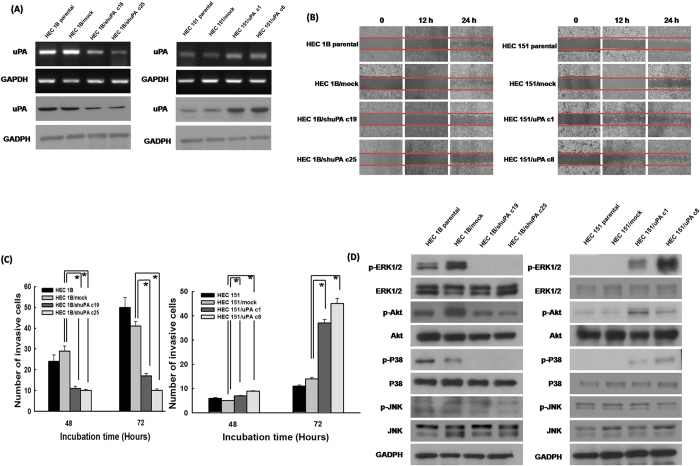
The expression level of uPA correlated with the migration and invasion of endometrial tumor cells and the phosphorylation of ERK1/2, Akt and p38 phosphorylation.(A) RT-PCR and Western blot analyses of uPA expression in various endometrial tumor cells and their transfectants. Note: The expression levels of uPA decreased in HEC1B/shuPA c19 and HEC1B/shuPA c25 cells compared to those in HEC1B parental and HEC1B/mock cells. However, the expression levels of uPA in HEC151/uPA c1 and HEC151/uPA c8 cells were higher than those in HEC151 parental and HEC151/mock cells. (B) Representative images of migration assays in various endometrial tumor cells and their transfectants. Note: Both HEC1B/shuPA c19 and HEC1B/shuPA c25 cells with a low uPA expression showed significantly fewer migrating cells than parental HEC1B and HEC1B/mock cells. However, both HEC151/uPA c1 and HEC151/uPA c8 cells with a high uPA expression had more migrating cells than the parental HEC151 and HEC151/mock cells. (C) Bar graph depicting the number of invasive cells by Boyden chamber analysis. Note: The low uPA-expressing HEC1B/shuPA c19 and HEC1B/shuPA c25 cells had a lower number of invasive cells than the parental HEC1B or HEC1B/mock cells (* indicates p < 0.001, one-way ANOVA). However, the high uPA-expressing HEC151/uPA c1 cells and HEC151/uPA c8 cells had a 2-fold higher number of invasive cells at 72 hours compared with the parental HEC151 and HEC151/mock cells (* indicates, p < 0.001, one-way ANOVA). (D) Western blotting analysis of phosphorylation of ERK1/2, Akt, JNK and p38 molecules. The phosphorylation of ERK1/2, Akt and p38 was consistently downregulated when the expression of uPA in tumor cells (HEC1B/shuPA c19 and HEC1B/shuPA c25 cells) decreased. The uPA highly-expressing tumor cells (HEC151/uPA c1 and HEC151/uPA c8 cells) revealed higher ERK1/2, Akt and p38 phosphorylation.